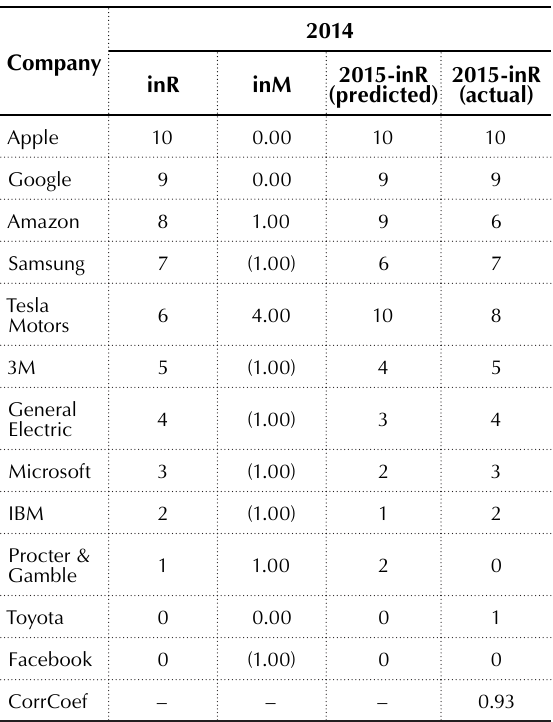
Table 3. Predicted versus actual values of normalized Innovation Ranking for the top 12 innovators for 2015 based on 2014 ranking